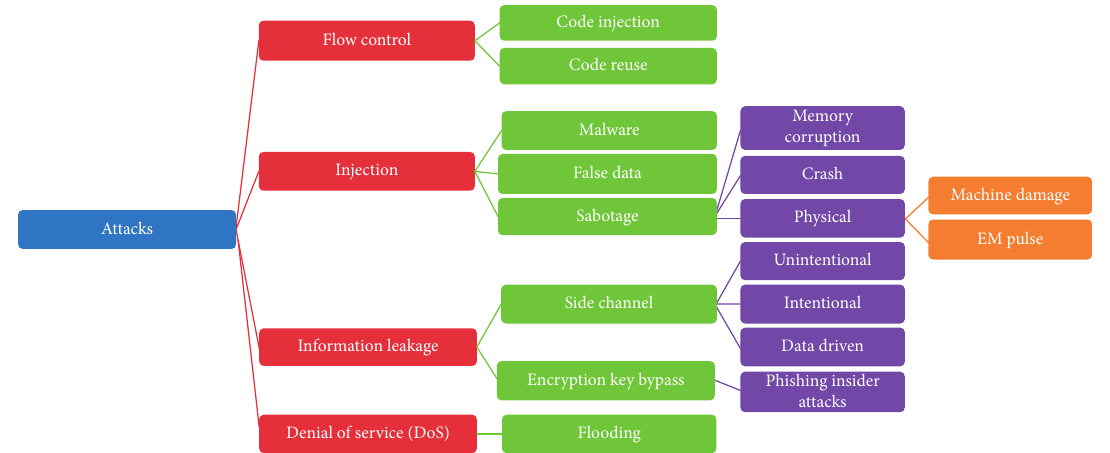
Figure 3: Cybersecurity attacks